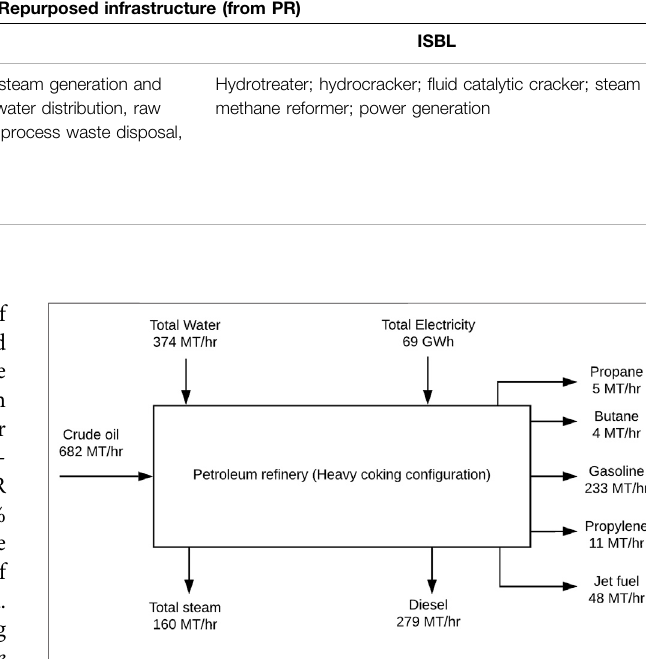
FIGURE 2 | Process fl ow diagram for a 120,000 BPD or 682 MT/hr petroleum re fi nery; The entities that were essential to determine the extent of integration strategies were reported in this fl ow